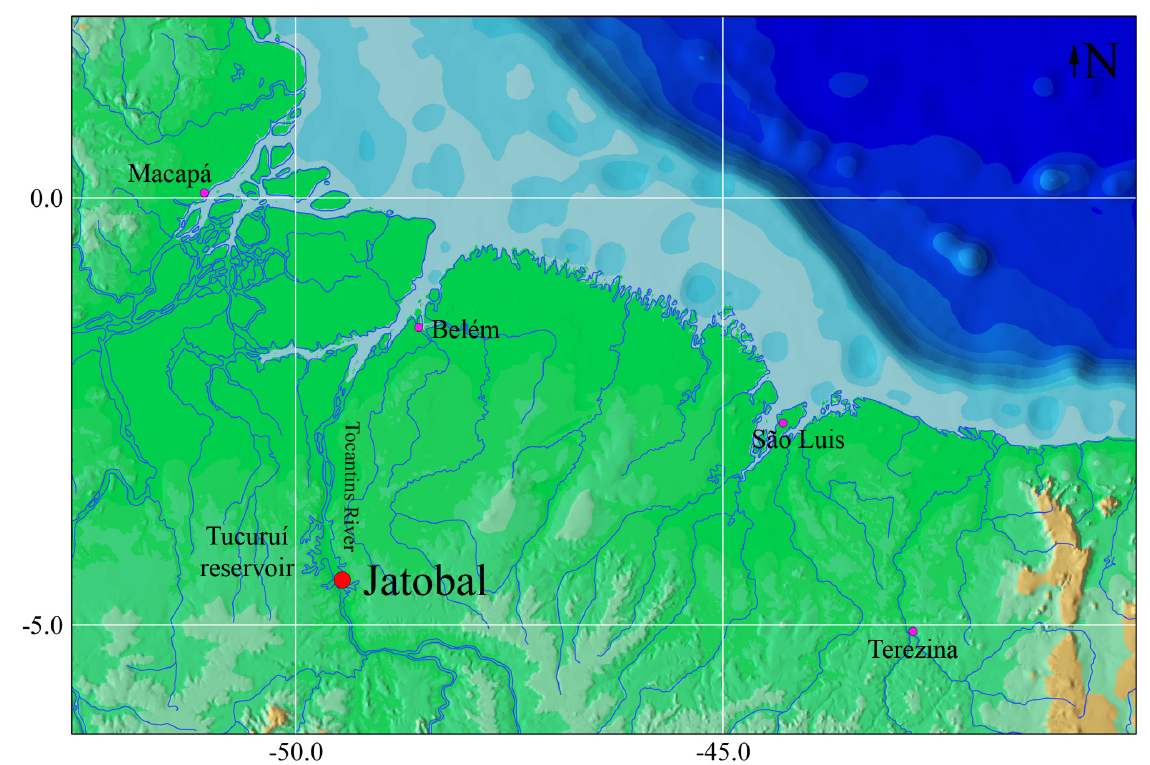
FIGURE 6 | Map of Jatobal localization (red dot) in the rio Tocantins, type locality of Rhyacoglanis rapppydanielae , currently flooded by Tucuruí reservoir, state of Pará, Brazil. Pink dots = state